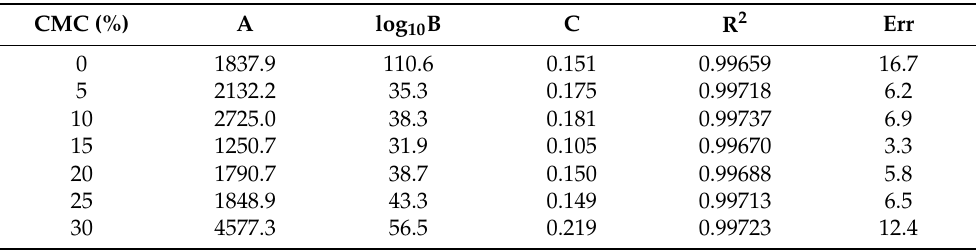
Table 4. Parameters of the fittings of the T 2 distributions, using a log-Gaussian function, presented in Equation